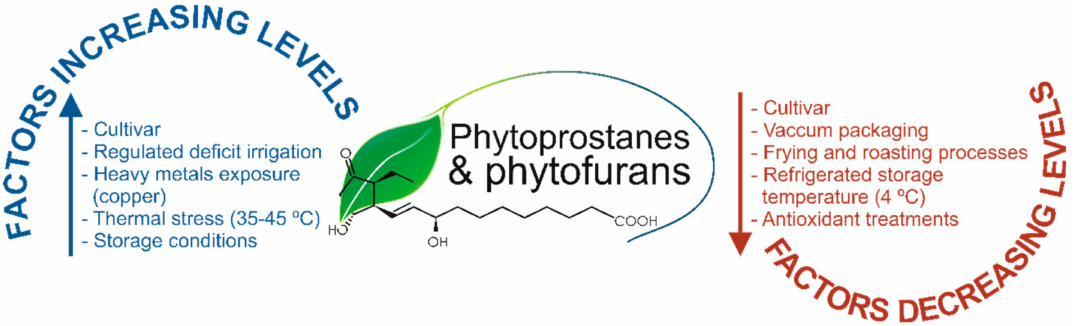
Figure 1. Factors modulating the oxylipins levels in plant